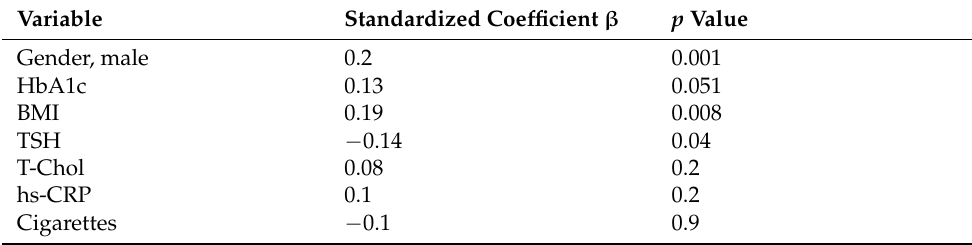
Table 4. Multivariate linear regression analysis for API. R 2 = 0.17; p =